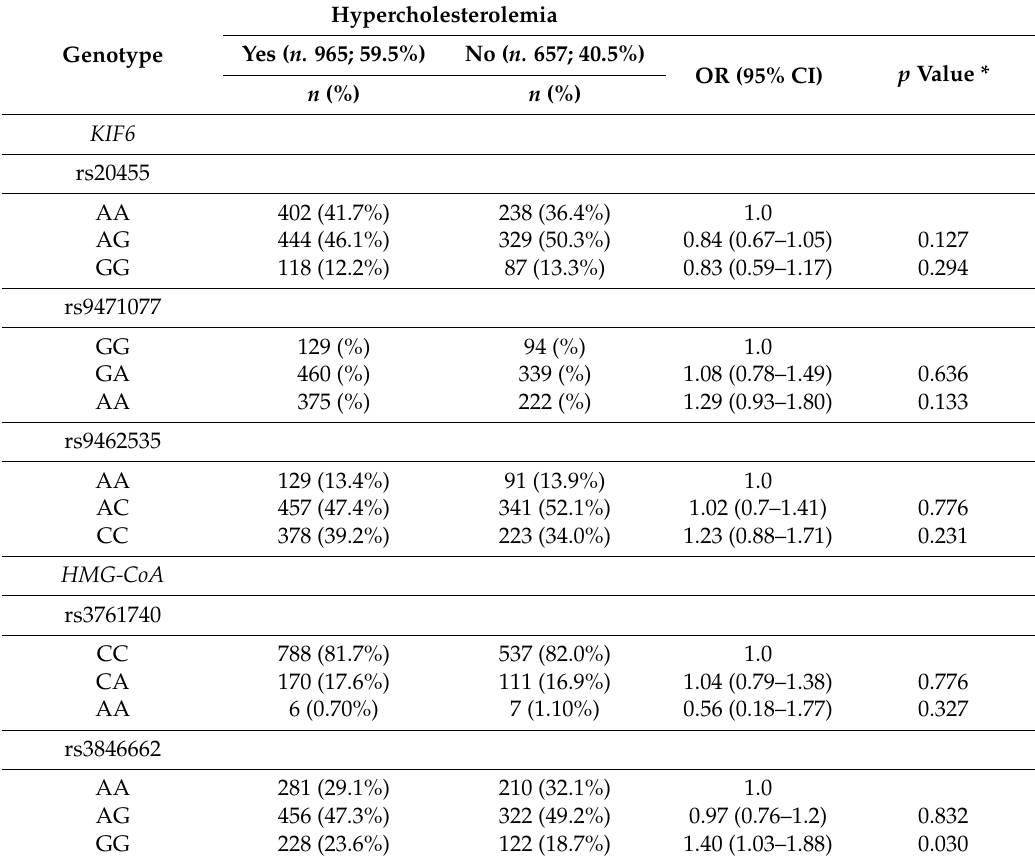
Table 3. Influence of KIF6 and HMG-CoA genotypes on hypercholesterolemia (TC >200 mg/dL) †